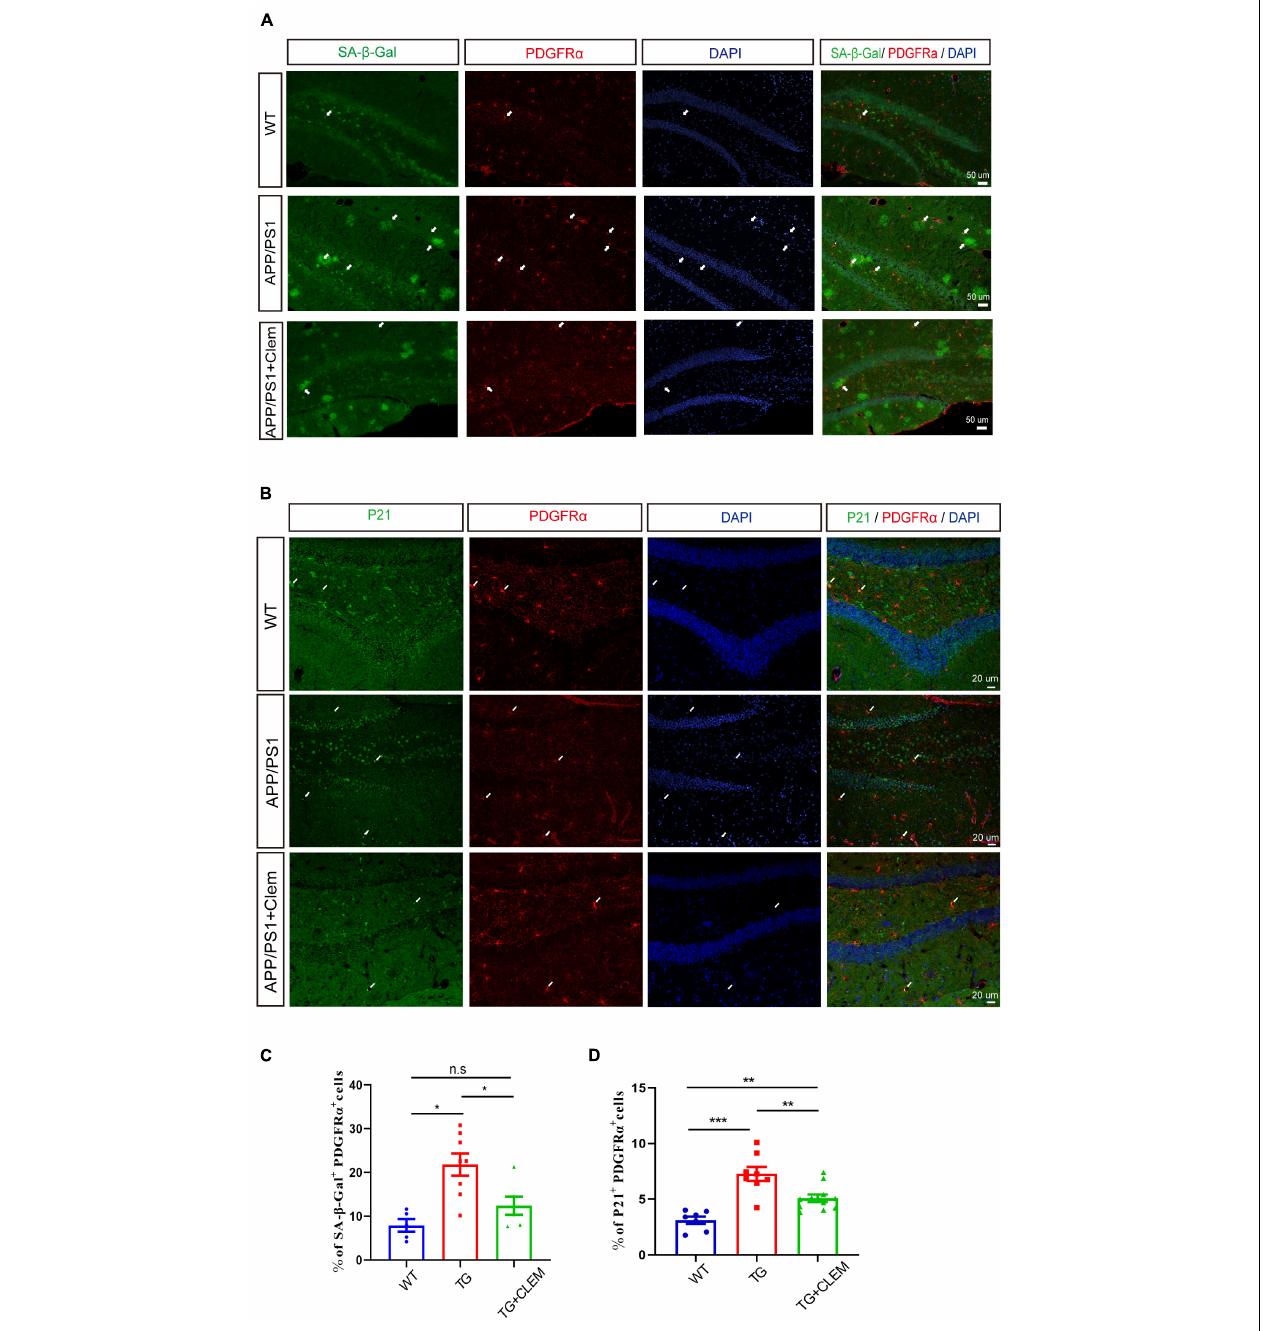
FIGURE 7 | Clemastine treatment prevents senescence of OPCs in aged APP/PS1 mice brain. (A,B) Confocal images of immunolabeling hippocampal OPCs with PDGFR α (red) and 4,6-diamidino-2-phenylindole (blue) and SA- β -gal (A) or p21 (green) (B) in WT; APP/PS1 and APP/PS1 mice treated with clemastine. (C,D) Quantification of percentage of SA- β -gal + PDGFR α + (C) or p21 + PDGFR α + (D) cells. Values shown are mean ± SE. * p < 0.05, ** p < 0.01, *** p < 0.001, n = 3 mice per group, one-way analysis of variance with Student’s t